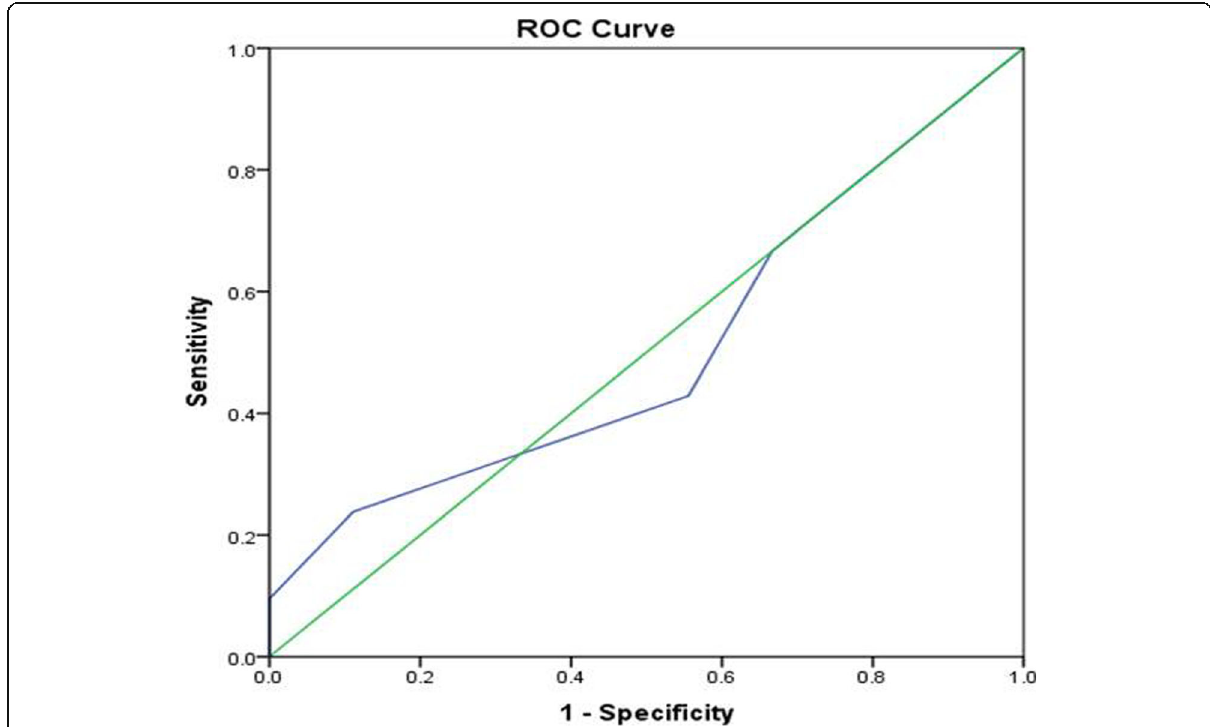
Fig. 1 ROC analysis of ADC values for predicting resectability. ADC values could not discriminate between resectable and unresectable lesions ( P value